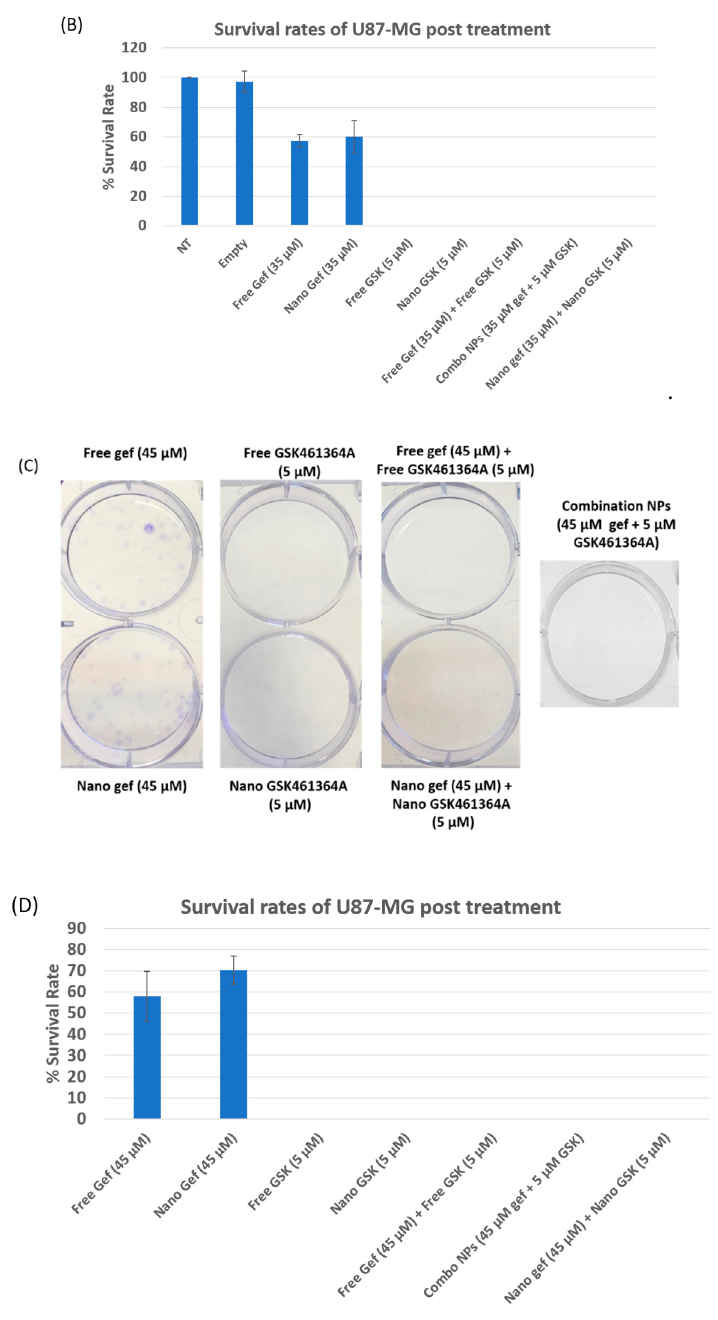
Figure 10. Colonies formed by U87-MG cells post treatment with combination NPs of different concentrations, single drug loaded NPs, respective free drug equivalents and control ( A , C ); Quantified cell colony formation data with the error bars indicating standard deviation of three repeats ( B , D ). NT: No Treatment.